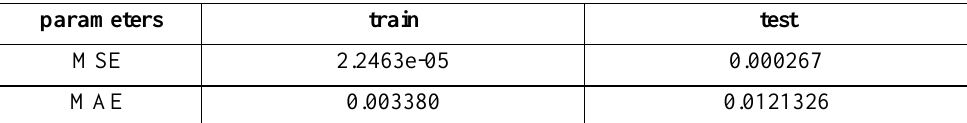
Figure 7. GRU predictions using the train dataset Table 3. Results of the GRU